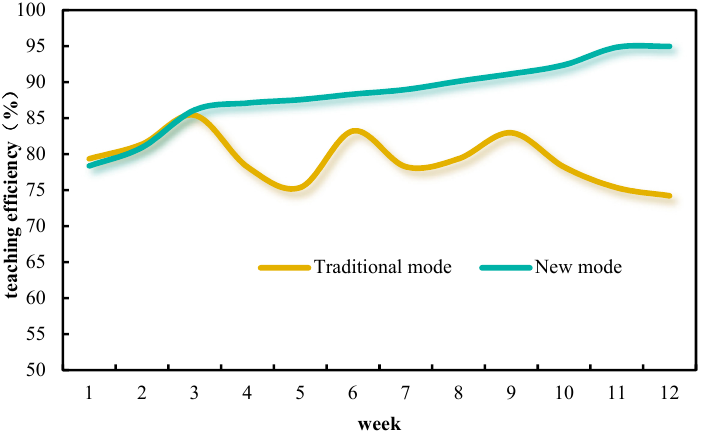
Figure 7. Teaching efficiency of 12 weeks under two